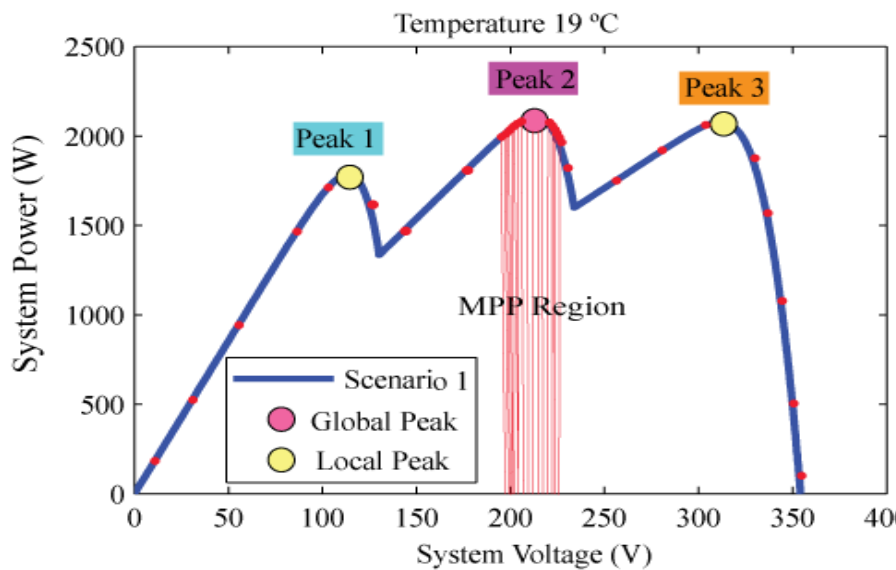
Figure 12. PV characteristics curve for scenario one.